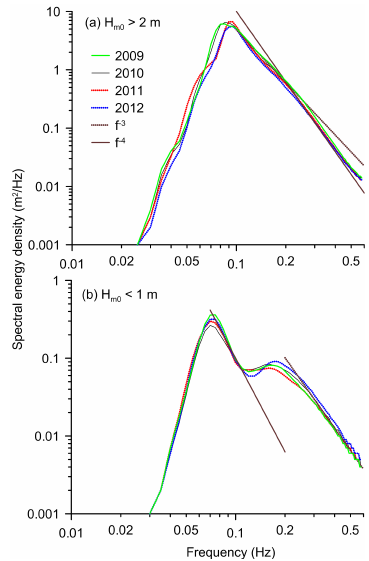
Figure 9. Annual averaged wave spectra for different years for waves with significant wave height (a) more than 2m and (b) less than 1m.